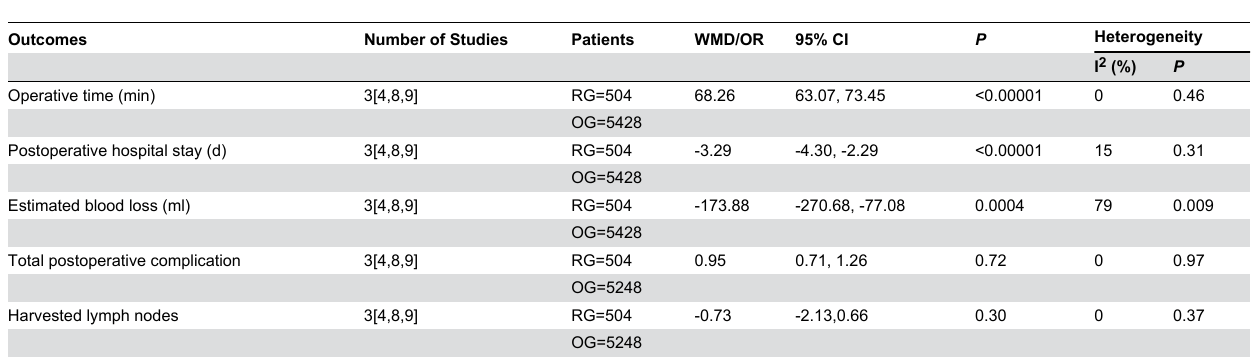
Table 2. Sensitivity analysis of